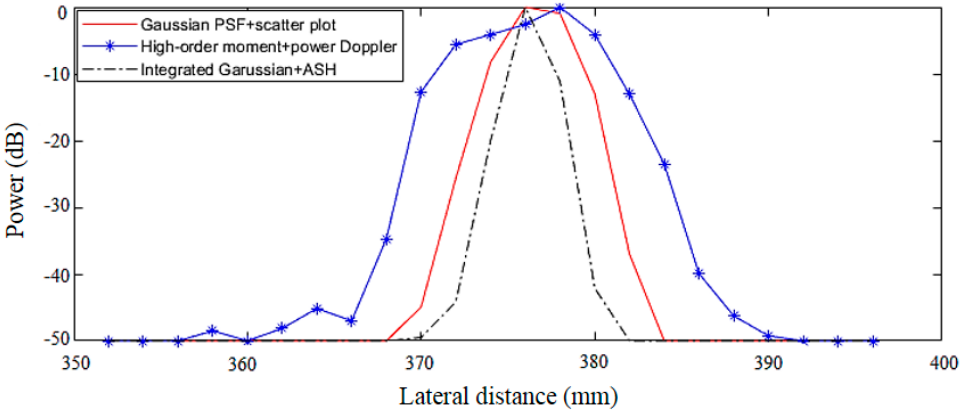
Figure 5. Locally magnified (10 times) microvascular images of rabbit kidney using: ( a ) Gaussian PSF deconvolution + scatter plot, ( b ) High-order moment calculation + power Doppler integration, and ( c ) Integral form of Gaussian PSF deconvolution + ASH respectively. All images are shown with a dynamic range of 50 dB.